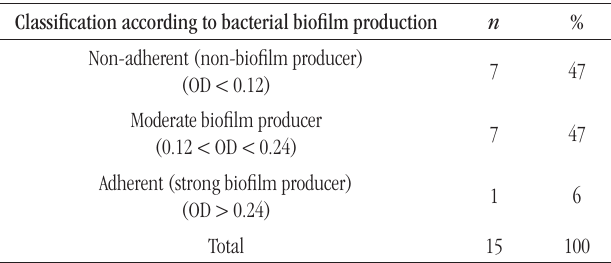
taBLE − Enterobacter sp. strains isolated from PU exudate among internal medicine inpatients, Petrolina (PE) – classification